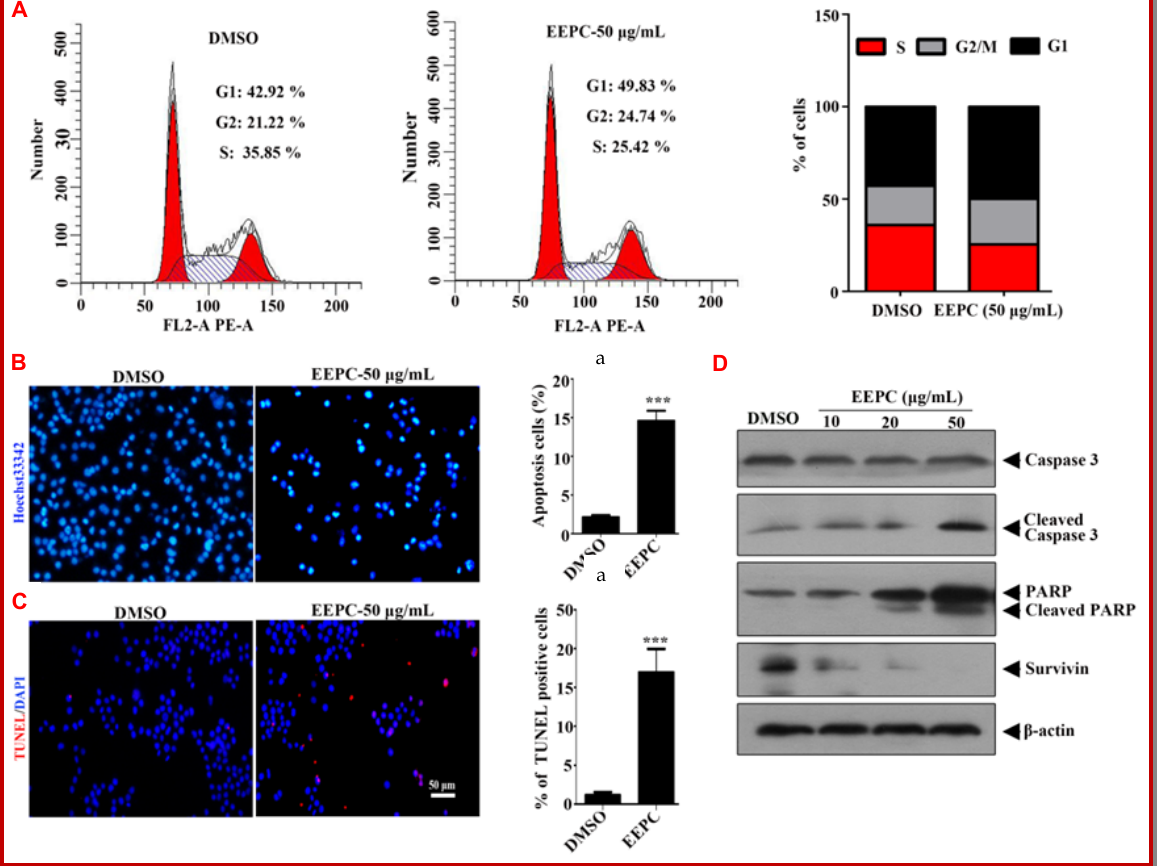
Figure 3: Effect of P. cocos (EEPC) on Neuro-2a cell cycle and apoptosis. The cell cycle was assayed by flow cytometry. The per- centages of cell cycle phases were displayed in bar charts (A). Apoptosis cells were detected using Hoechst33342 fluorescent stain- ing. Neuro-2a cells were treated with P. cocos (50 µg/mL) for 24 hours.) (B). Cell apoptosis were determined by the TUNEL assay. TUNEL-positive cells are labeled were red fluorescent. Nuclei were stained with DAPI (blue), Scale bar, 50 µm. Bar graph showed the percentage of apoptotic cells. Error bars represent SEM (n = 3). a p<0.001, indicated compound vs DMSO, one-way analysis of variance (ANOVA) followed by Tukey’s test (C). Neuro -2a cells were treated with various concentration of P. cocos (10, 20 and 50 µg/mL) for 24 hours. The expression of caspase 3, cleaved-caspase 3, PARP, cleaved-PARP and survivin were analyzed by